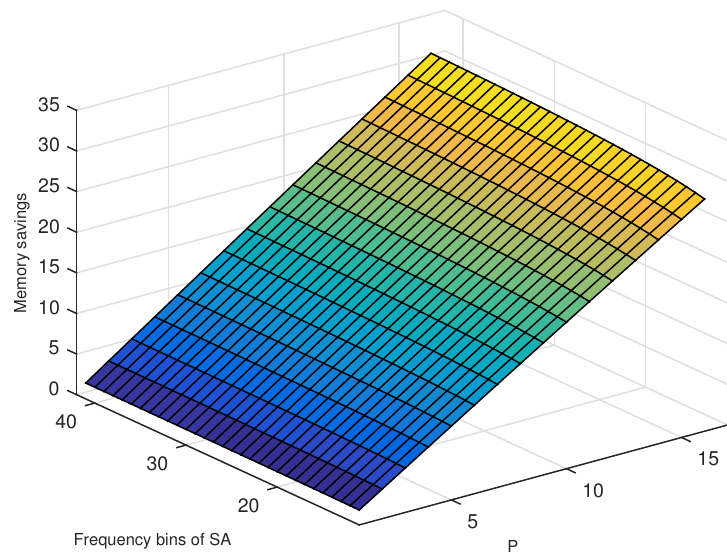
Figure 7. Comparison of memory usage of SA versus VTTS. The depicted values represent the amount of memory savings obtained by VTTS over the